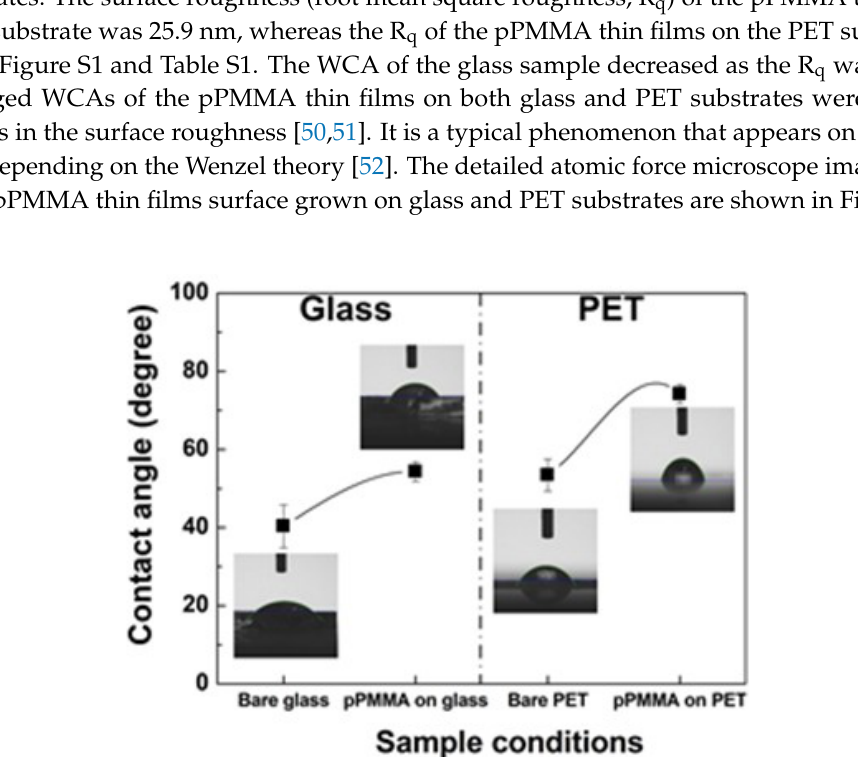
Figure S1: Two- (2D) and three-dimensional (3D) AFM images of pPMMA film surfaces grown on glass and PET substrates when using the proposed APP polymerization technique after 90 min deposition, Table S1: Root mean square roughness (R q ) and average roughness (R a ) obtained from AFM images of pPMMA film surfaces grown on glass and PET substrates when using the proposed APP polymerization technique after 90 min deposition. Author Contributions: C.-S.P., E.Y.J., and H.-S.T. conceived and designed the study; C.-S.P., E.Y.J., H.J.J., and